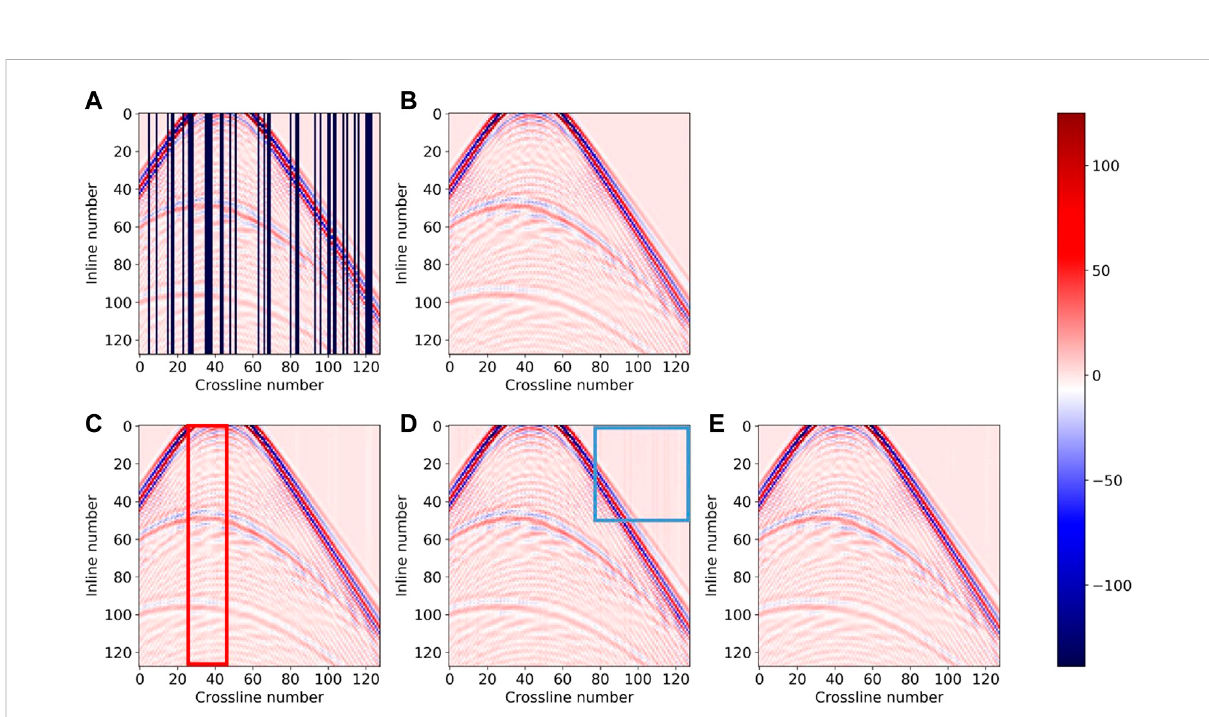
FIGURE 17 Interpolationresults using differentloss functions and normalization methods on theSEG C3 syntheticdata: (A) missing traces data, (B) ground truth, (C) swichnorm+MSE loss, (D) batchnorm+hybrid loss, and (E) swichnorm+hybrid loss.